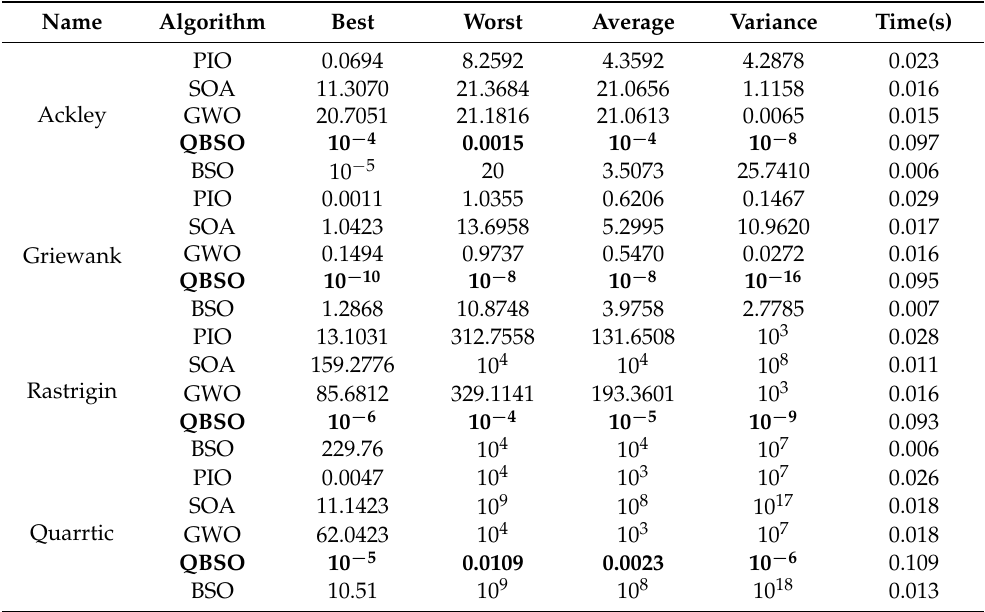
Table 6. Results of the multimodal benchmark function experiments (population size =